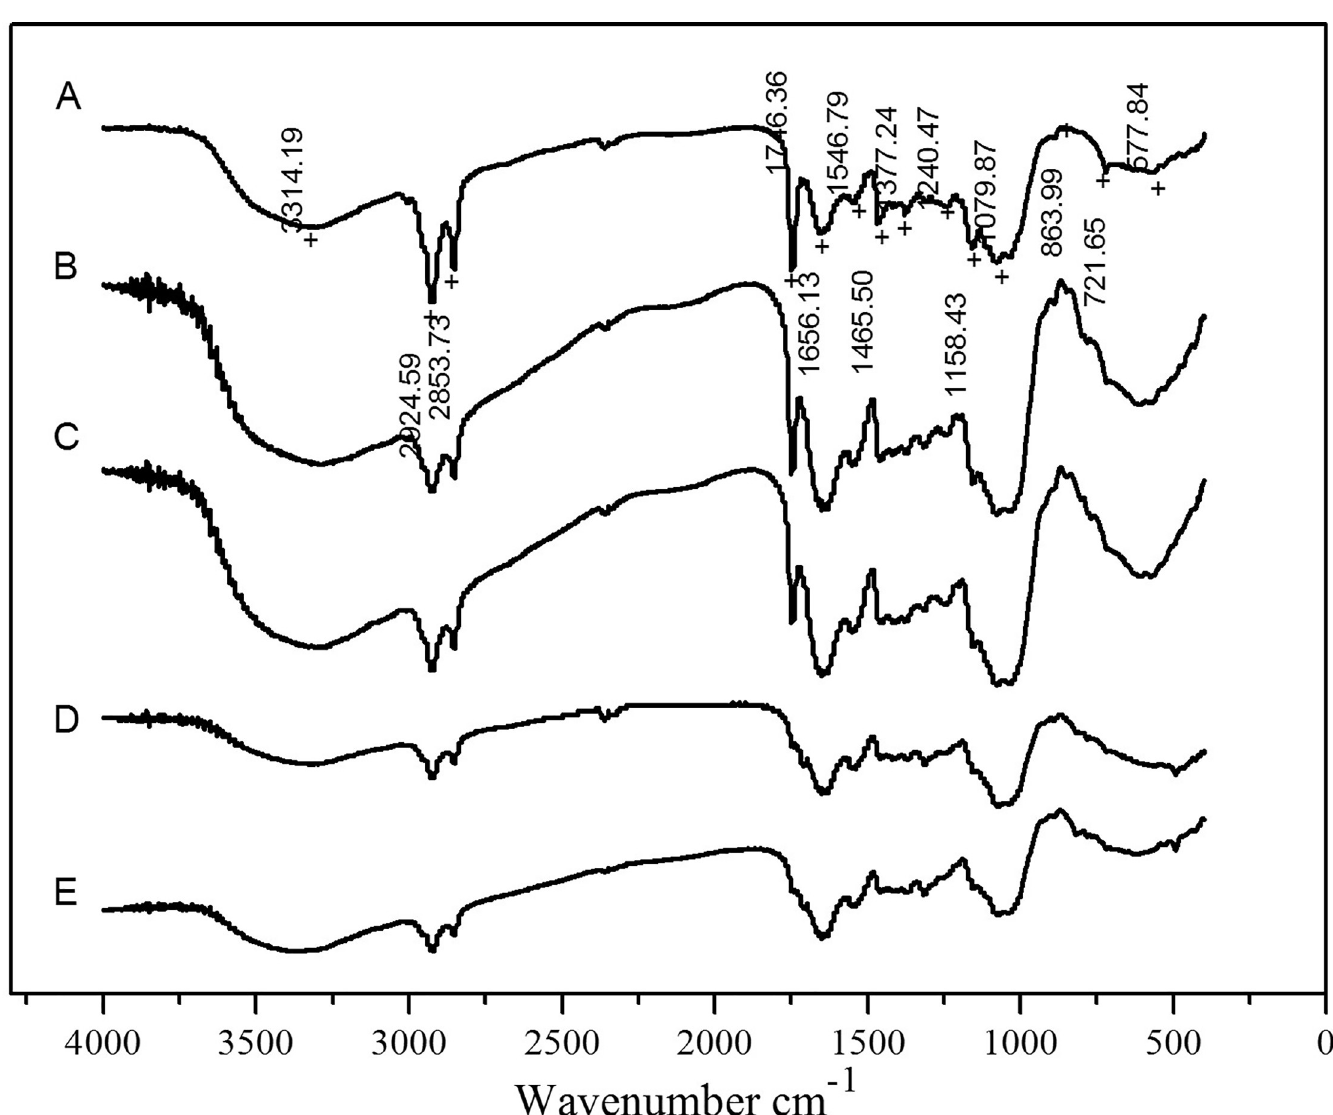
Fig 7. FTIR spectra of growing Verticillium insectorum J3 cells under different Pb(II) and Zn(II) concentrations. A is the control treatment; B, C, D, E are metal- loaded J3 cells (50, 100, 200, 300 mg L -1 , respectively). Biosorption conditions: initial pH = 4, initial Pb(II) and Zn(II) concentration (0,50,100,200,300 mg L -1 , respectively), absorption time 7 days, initial biomass does 2mL L -1 , temperature